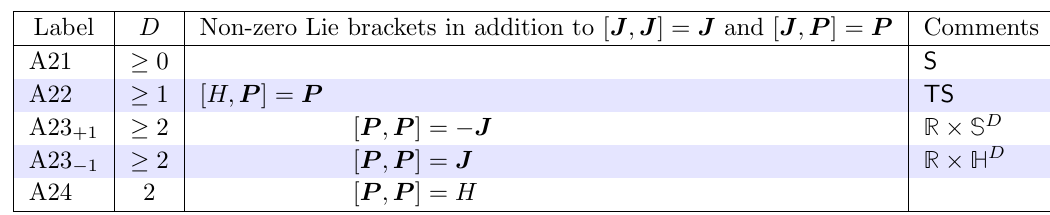
Table 2 . Simply-connected homogeneous ( D + 1)-dimensional aristotelian spacetimes. For further properties see table 3.